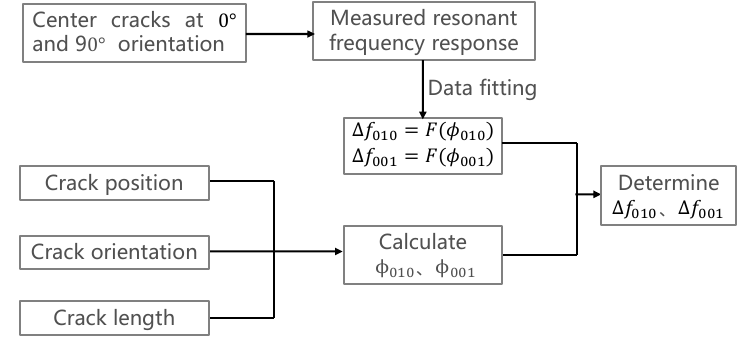
Figure 9. Algorithm for predicting the crack-caused resonant frequency shifts.